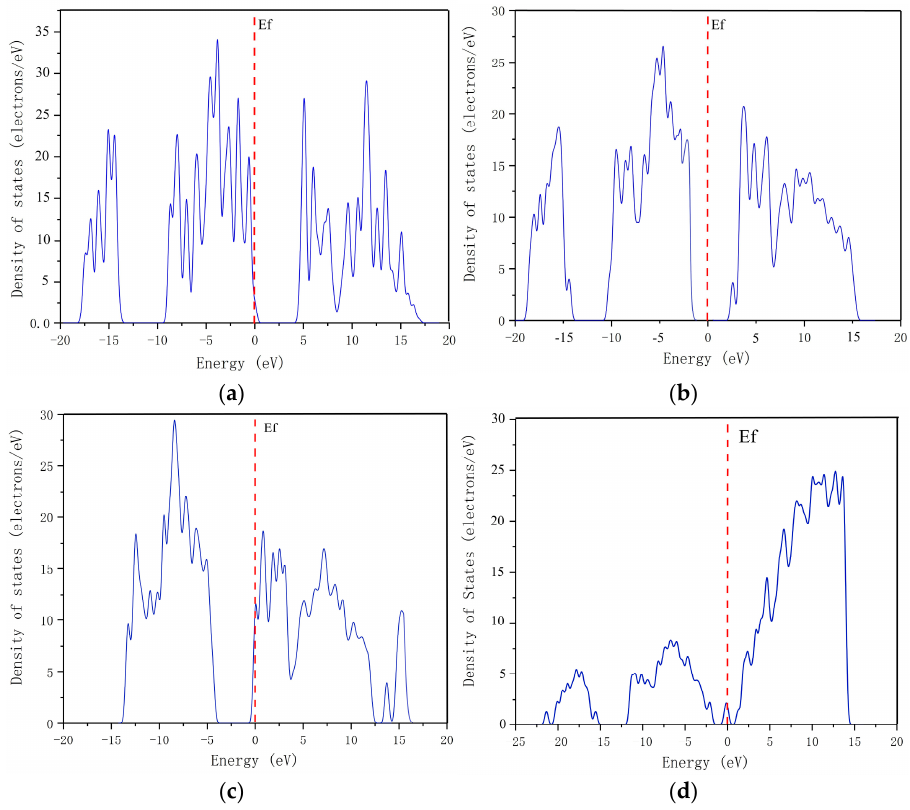
Figure 5. Total density of states for ( a ) intrinsic, ( b ) Cs − doped, ( c ) Br − doped, and ( d ) Cs − Br co − doped h −